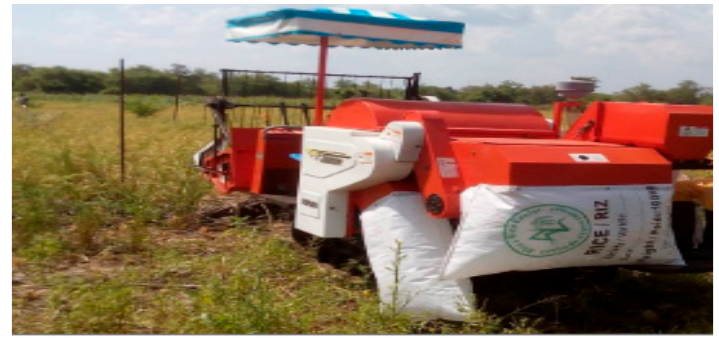
Figure 11. Collection of grain losses in a woven sack at the rear and concave of the machine [41]. In order to measure the losses at the header of the combine, the machine was driven in the field and, after achieving a steady-state condition, it was stopped. Then the combine was back up a distance equal to the longitudinal distance between the cutter bar and the discharge chute. The sample area was marked off in front of the combine, and the losses collected from the area were weighed as the header loss